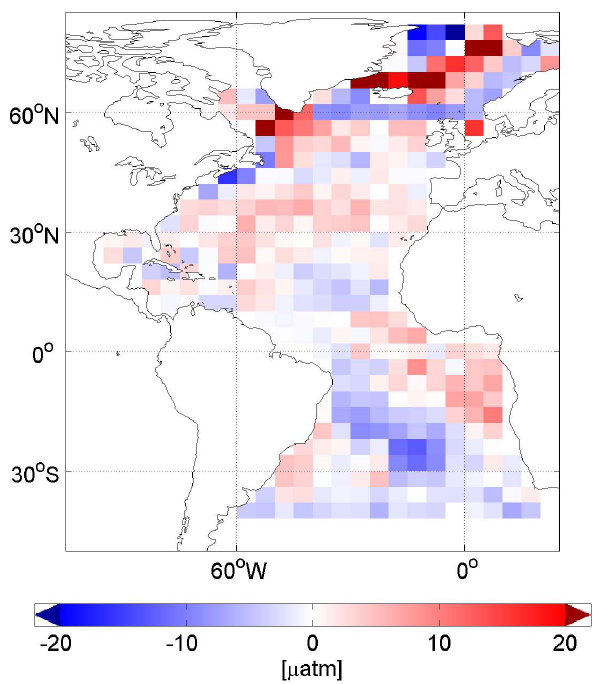
Fig. 7. Difference in the surface ocean p CO 2 inµatm between the decadal mean neural network estimates (this study), corrected to the year 2000, and the estimates from the climatology of Takahashi et al. (2009). Positive differences indicate higher p CO 2 for the neu- ral network estimates. The neural network estimates have been in- terpolated to the (4 ◦ × 5 ◦ ) grid of the Takahashi